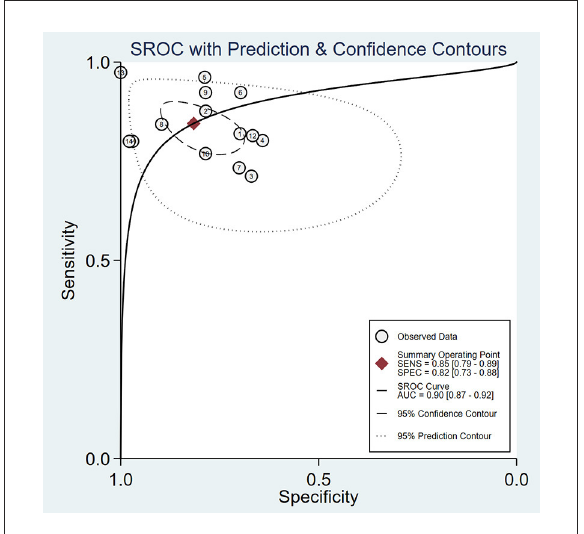
FIGURE3 Summary receiver operating characteristic (SROC) curve of the diagnostic performance of ultrasound elastography for the diagnosis of biliary atresia (BA).